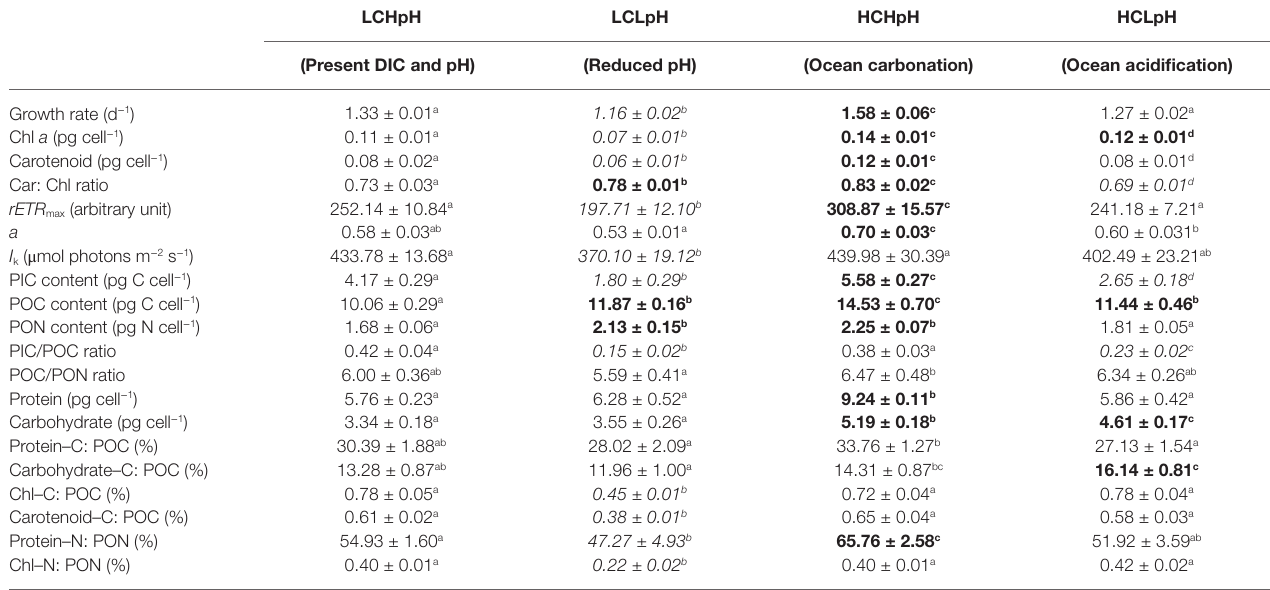
TABLE 3 | Summary of all parameters under four carbonate chemistry